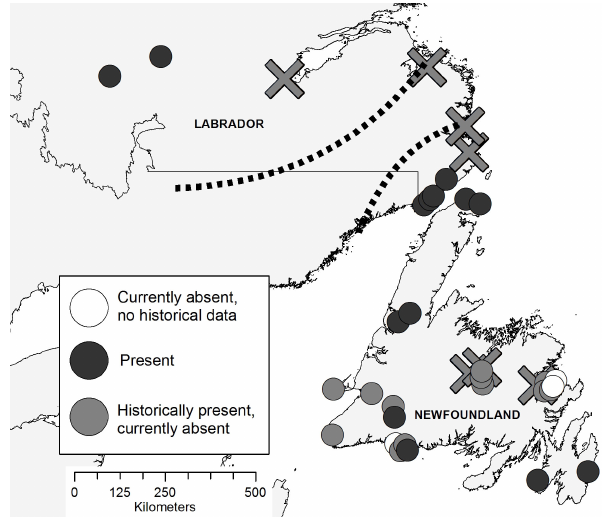
dotted lines represent the putative range gap between the subspecies. Some occurrence points have been offset to better show clustered survey